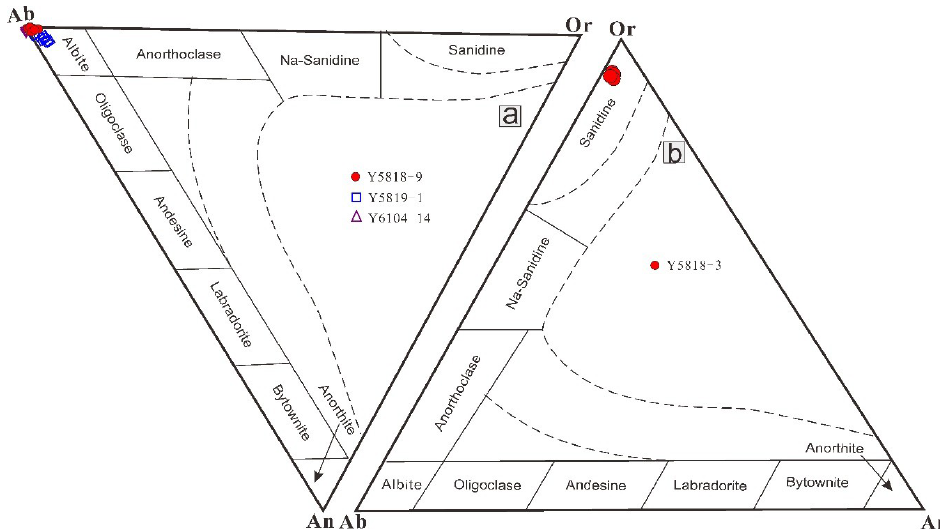
Figure 11. Albite–anorthite–orthoclase diagram (modified from [33]) for plagioclase minerals in the Yamansu deposit. Yamansu deposit.